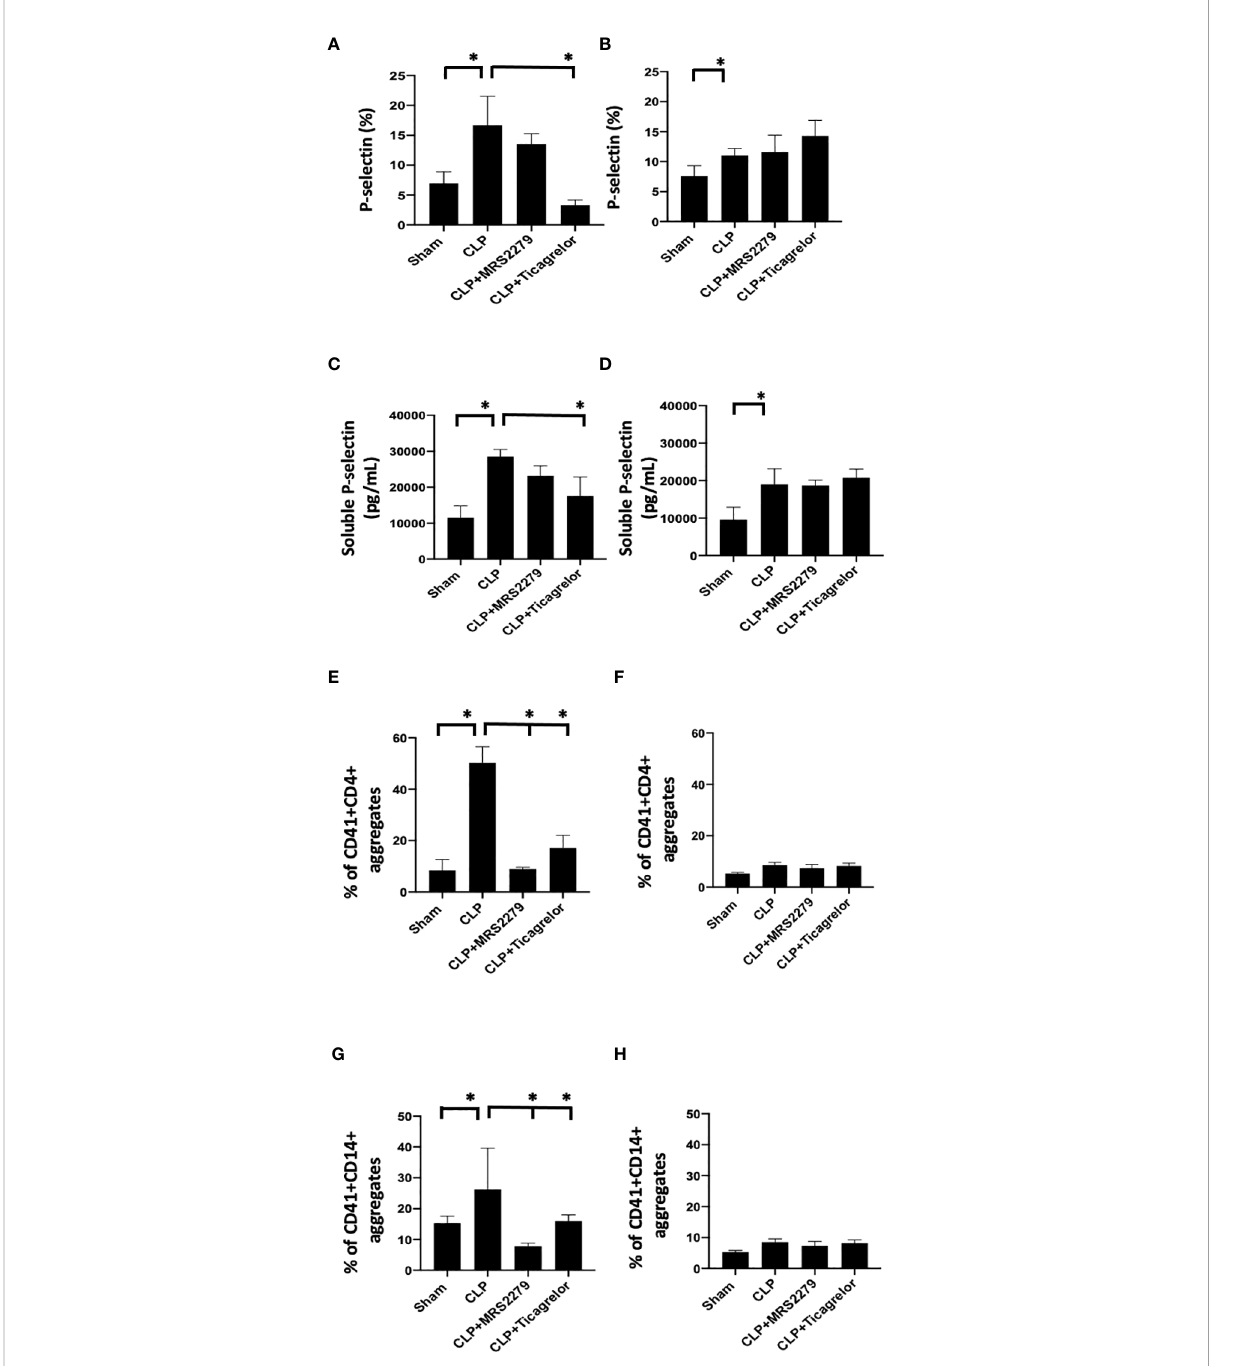
FIGURE 5 P2Y 12 or P2Y 1 antagonism alters sepsis-induced platelet activation, and platelet – leukocyte aggregate formation in a sex-speci fi c manner. (A, B) _Blood samples were collected by cardiac puncture in 3.8% sodium citrate (10:1) P-selectin expression on platelet surface was evaluated using fl ow cytometry in whole blood. Data were collected from Sham and CLP in male (A) and female mice (B) . Mice were untreated or treated with MRS (50mg/kg) or ticagrelor (30 mg/kg). Values are expressed as % of platelets positive to p-selectin, mean ± S.E.M. (*P < 0.05). (C, D) Soluble p-selectin was analyzed in the plasma collected from Sham and CLP male (C) and female (D) mice using an ELISA kit. Mice were untreated or treated with MRS (10mg/kg) or ticagrelor (10mg/kg). Values are expressed as pg/mL, mean ± S.E.M. (*P < 0.05). (E-H) Samples were collected from Sham and CLP male (E – G) and female (F – H) mice. Samples were incubated with antibodies against CD41 (platelet marker) and CD4 (T cell marker, E, F ) or CD14 (monocyte marker, G, H ). T cells or monocytes were gated based on CD4 or CD14 expression respectively and cell shape. Data were analyzed based on the percentage of aggregates that express both CD41 and CD4 (E, F) or CD14 (G, H) . Values are expressed as the percentage of CD41+/CD11b+ cells, mean ± SEM n =